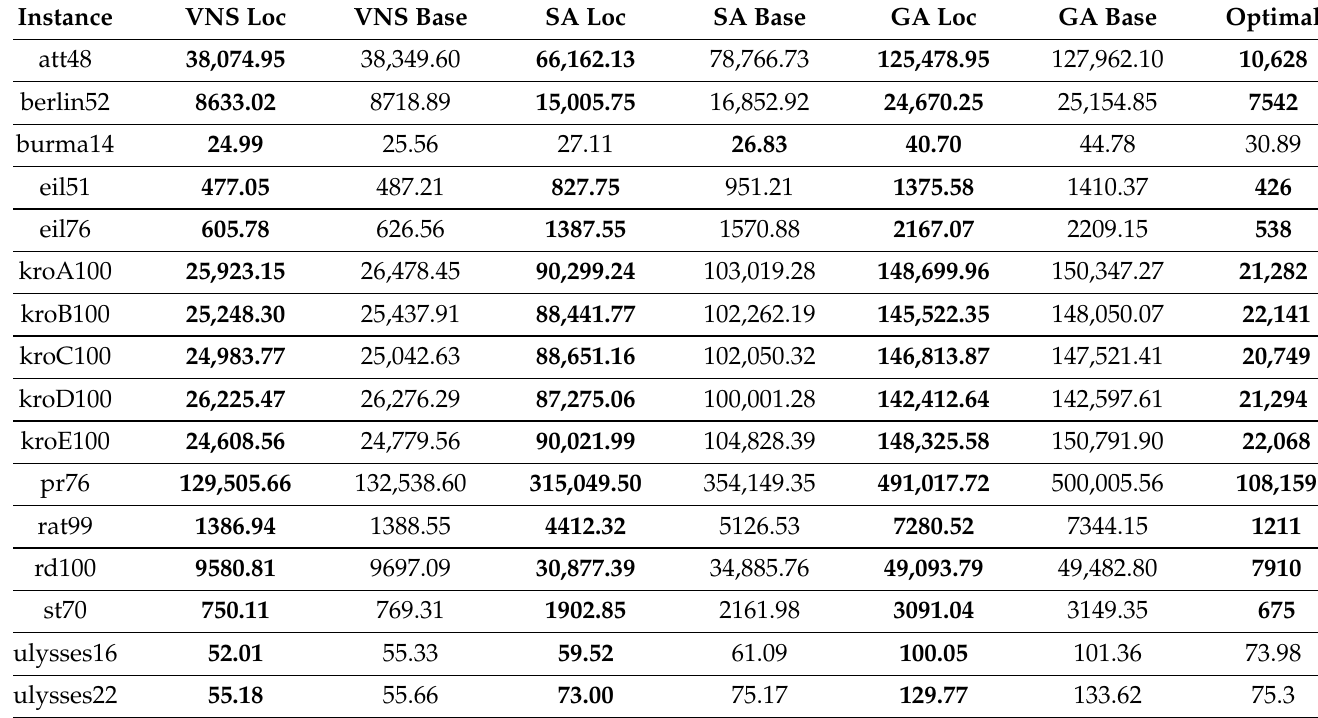
Table 3. Comparison between baseline (Base) and locus (Loc) mutation for three different algorithm ,genetic algorithm (GA), simu- lated annealing (SA) and Variable neighborhood search (VNS). We applied these algorithms on 16 different instances from TSPLIB dataset. In most cases, locus mutation is enhancing the performance of the